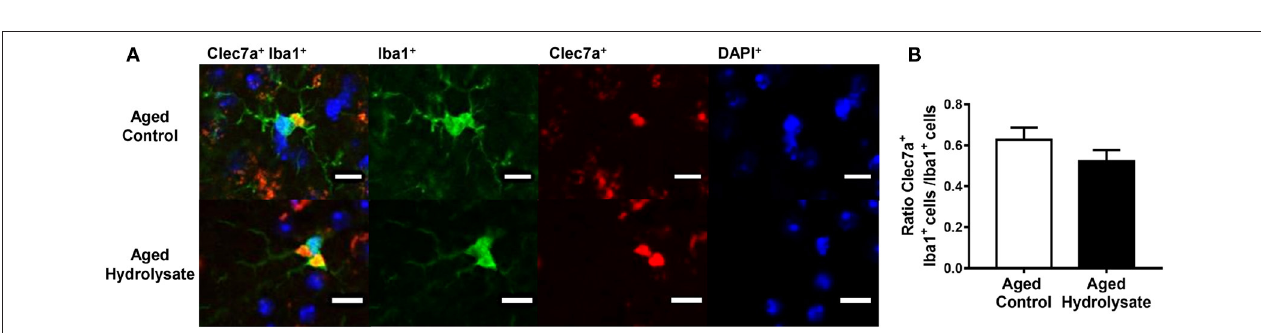
FIGURE 6 | Effects of the fish hydrolysate supplementation on MGnD microglial signature in the hippocampus. mRNA expression of MGnD microglial signature Trem2, ApoE, Axl, MHCII, Lgals3, Clec7a, and Itgax in the hippocampus of aged mice fed with the control diet or the hydrolysate-enriched diet for 10 weeks (* p < 0.05 by unpaired t -test; n = 8 per group). Data are presented as mean ± SEM.